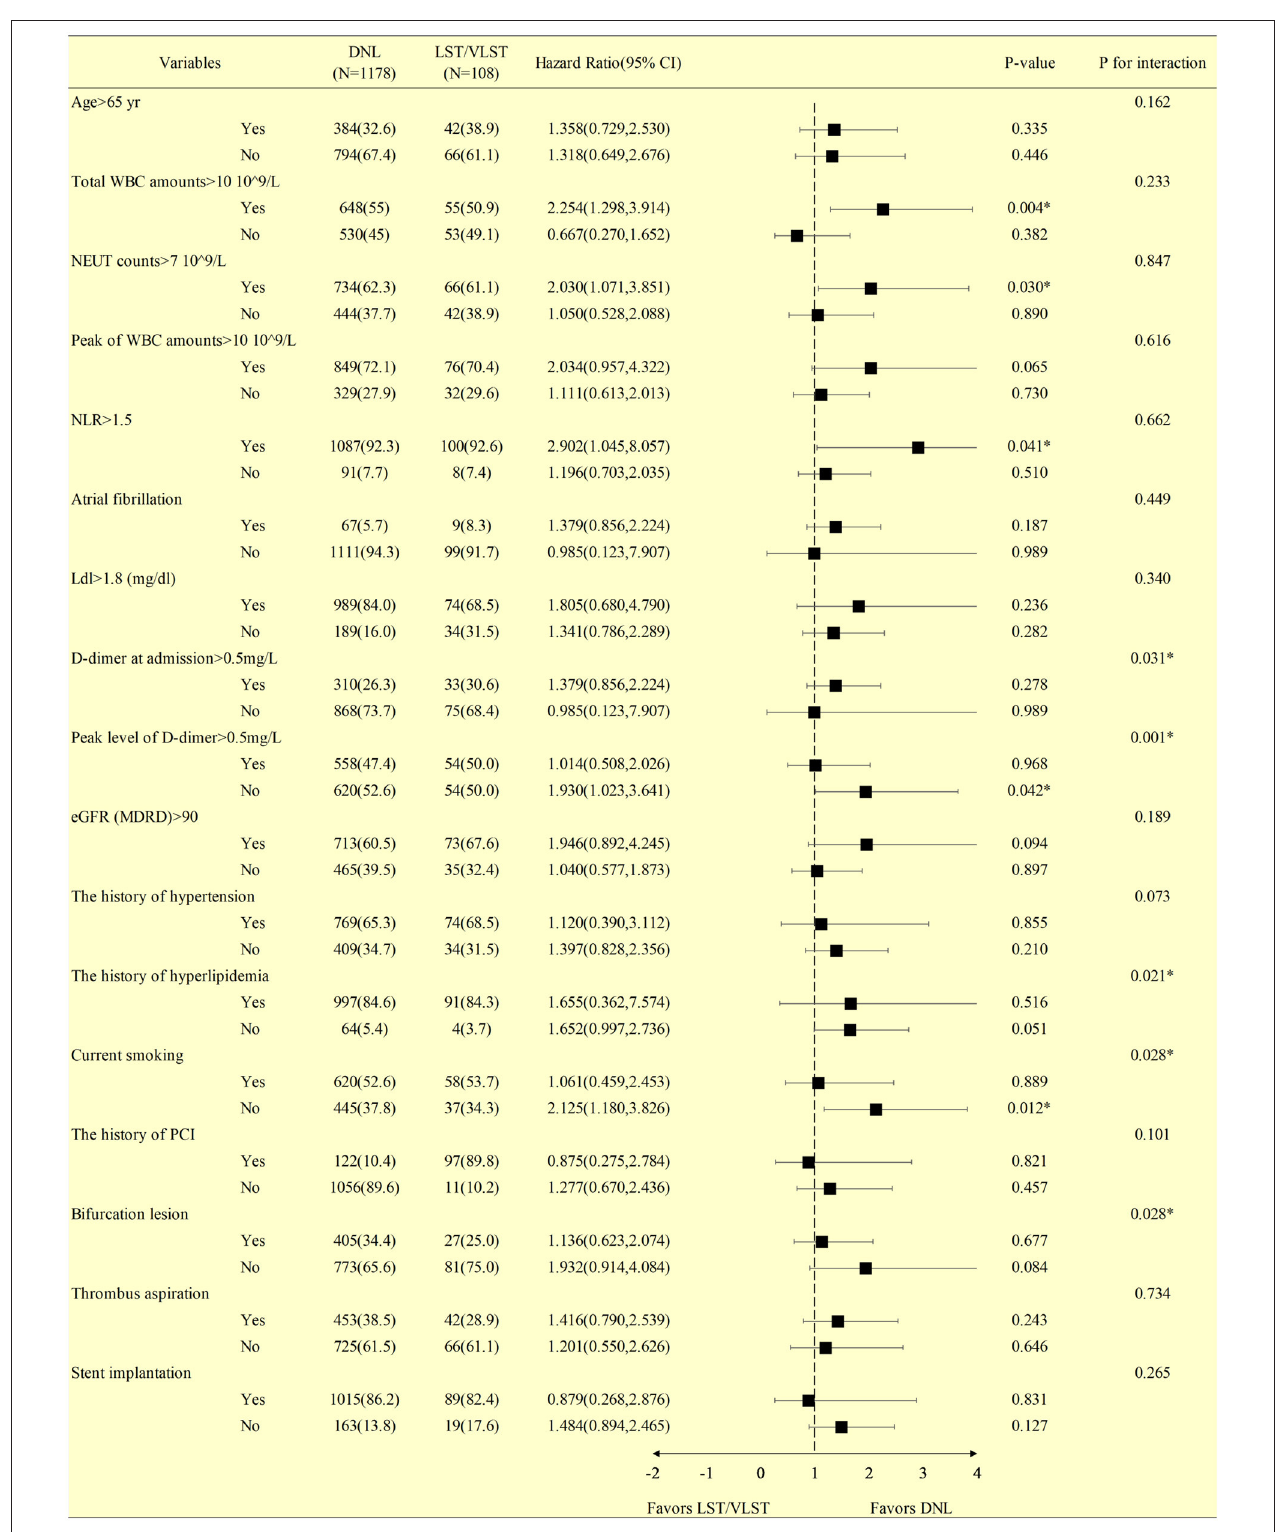
FIGURE 2 | Stratified analysis of the revascularization at a median follow-up of 698 days in patients with DNL or LST/VLST lesion. Values are n (%). The primary endpoint is revascularization. *Interaction is for risk ratio − 2 to 1 year and risk ratio 1–4 years for LST/VLST and DNL. DNL, de novo lesion; LST, late stent thrombosis; VLST, very late stent thrombosis; CI, confidence interval; WBC, white blood cell; NEUT, neutral granular cell counts; NLR, neutrophil–lymphocyte ratio; LDL, low-density lipoprotein; eGFR, estimated glomerular filtration rate; PCI, percutaneous coronary intervention.